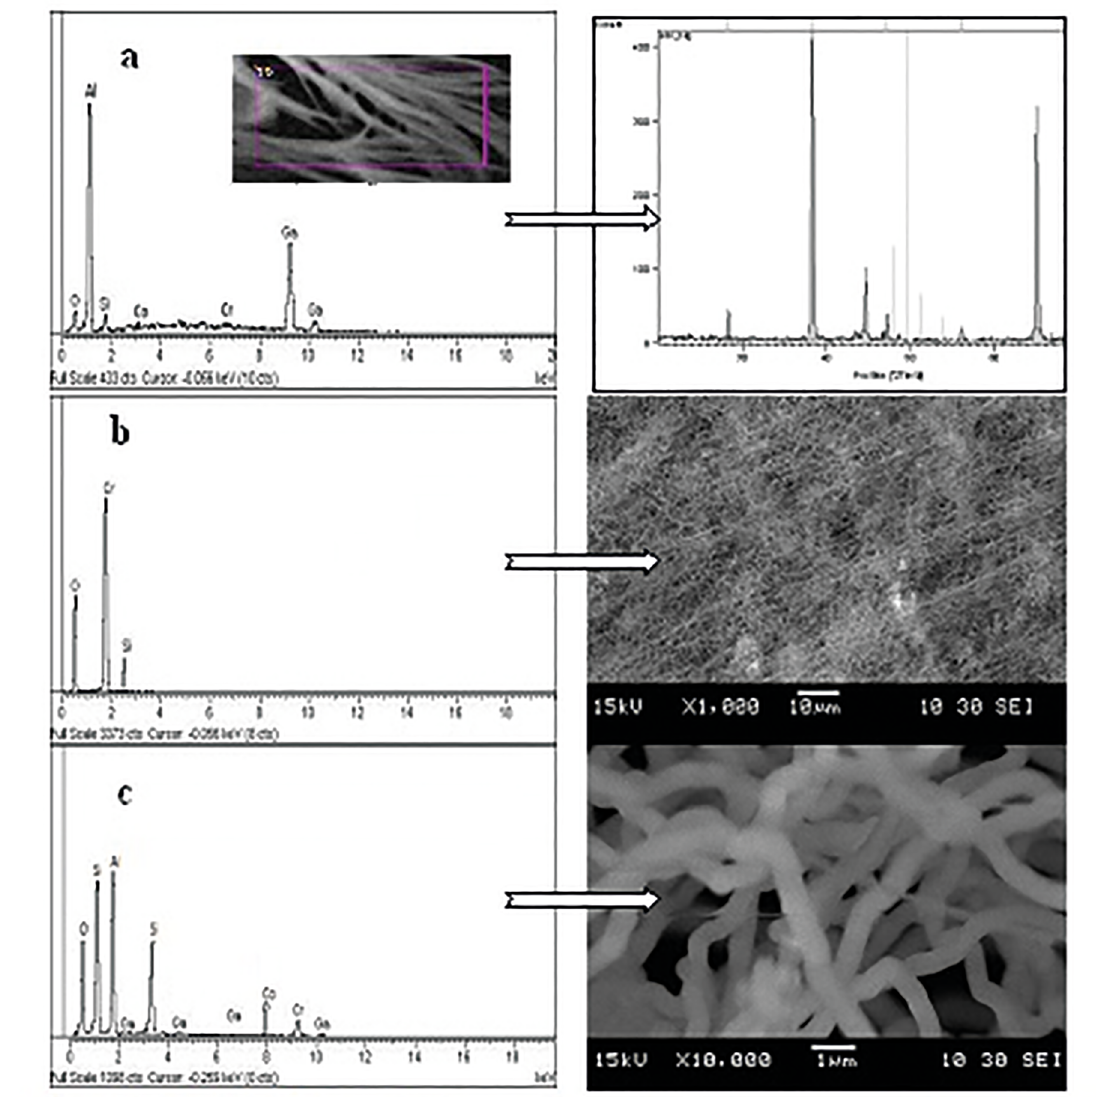
Figure 1. SEM and XRD of the composite coating at thickness 15 ± 0.05 µm (a), (b) SEM image of smooth coating surface and (c) wear particles. Corresponding